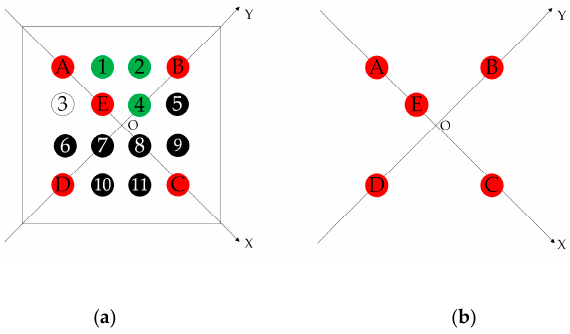
Figure 1. The encoding principle. ( a ) Structure of color-encoded target pattern. ( b ) Base points